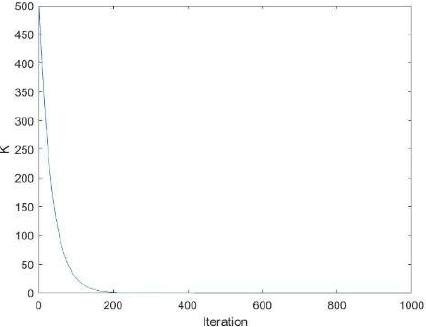
Figure 2. The iterative curve of the Coulomb constant.